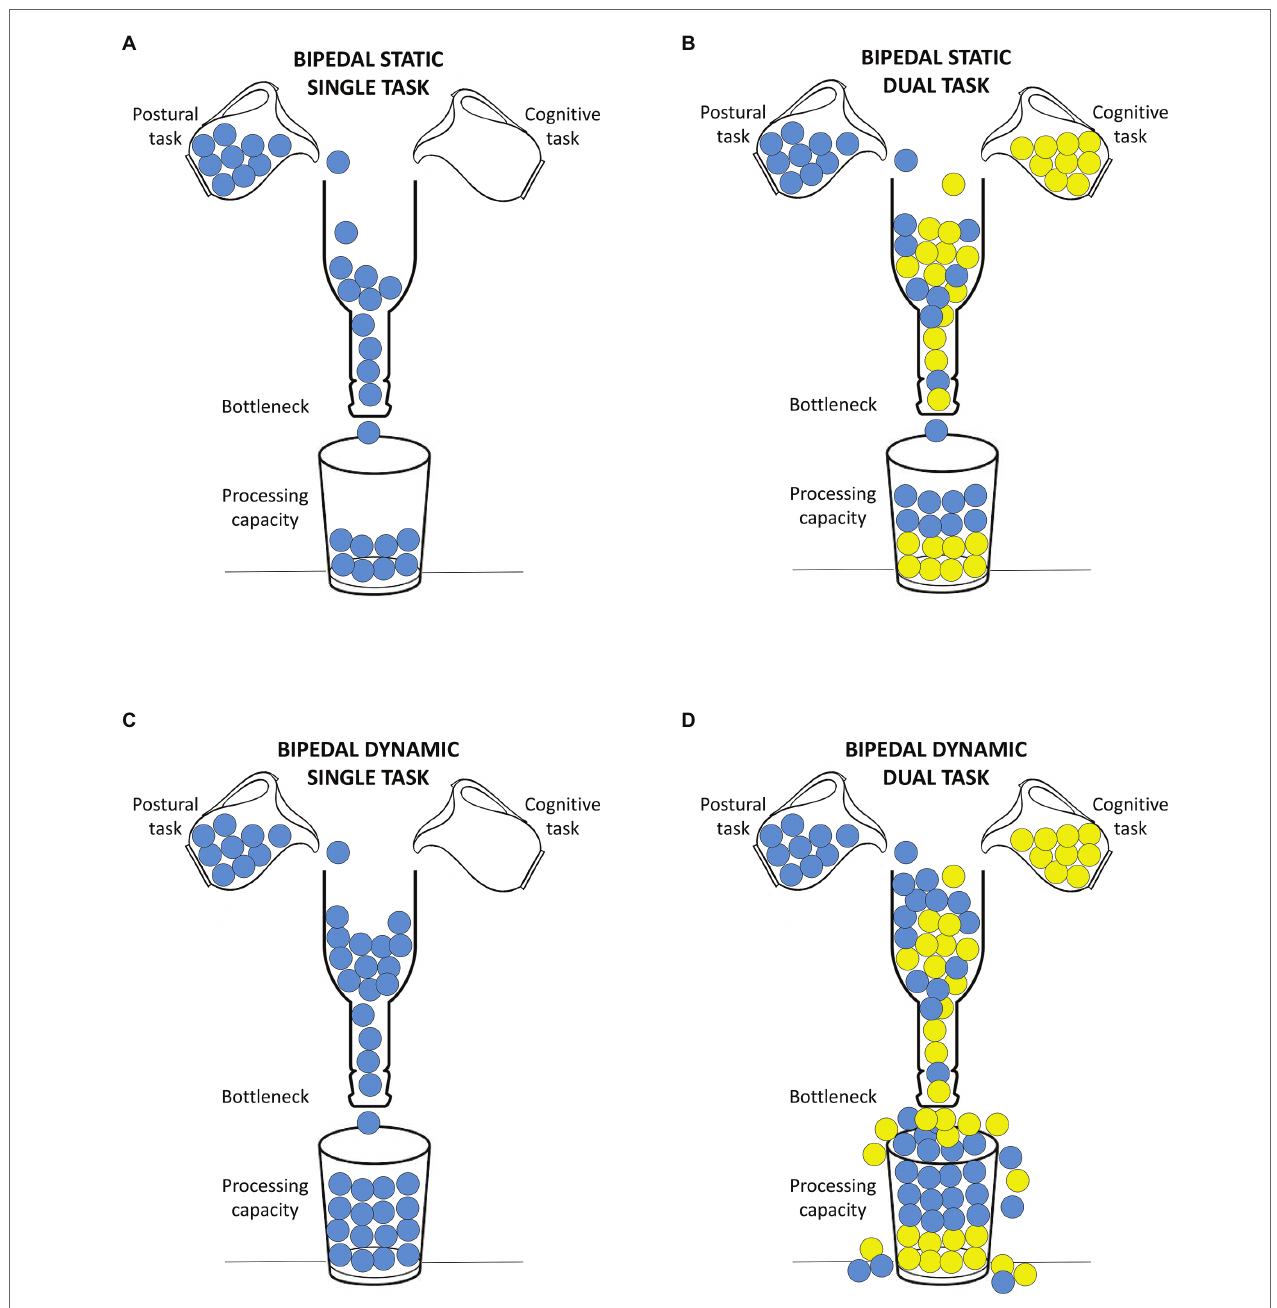
FIGURE 3 | Capacity sharing and bottleneck model approaches to explain dual-task interference. (A) Inputs from the postural task (blue balls) cover a small part of the whole processing capacity (few balls in the glass) due to the mostly automatic control involved in quiet standing. No bottleneck occurs in this condition. (B) Under the static dual-task condition, a bottleneck results since postural (blue balls) and cognitive (yellow balls) tasks require the same mechanism at the same time. Moreover, the presence of both tasks covers a considerable part of the whole processing capacity (higher number of balls in the glass). (C) The dynamic postural task requires more processing capacity than static postural task (i.e., more blue balls in the glass). No bottleneck occurs in this condition. (D) Under the dynamic dual-task condition, a bottleneck occurs as for (B) and the processing capacity required, exceeds its total amount (the balls overflow the